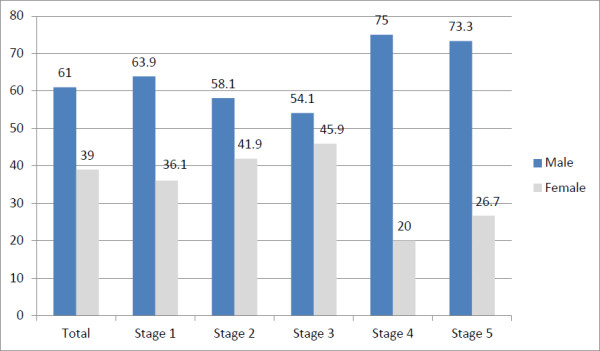
Prevalence of CKD and its stages by gender (using MDRD equation).